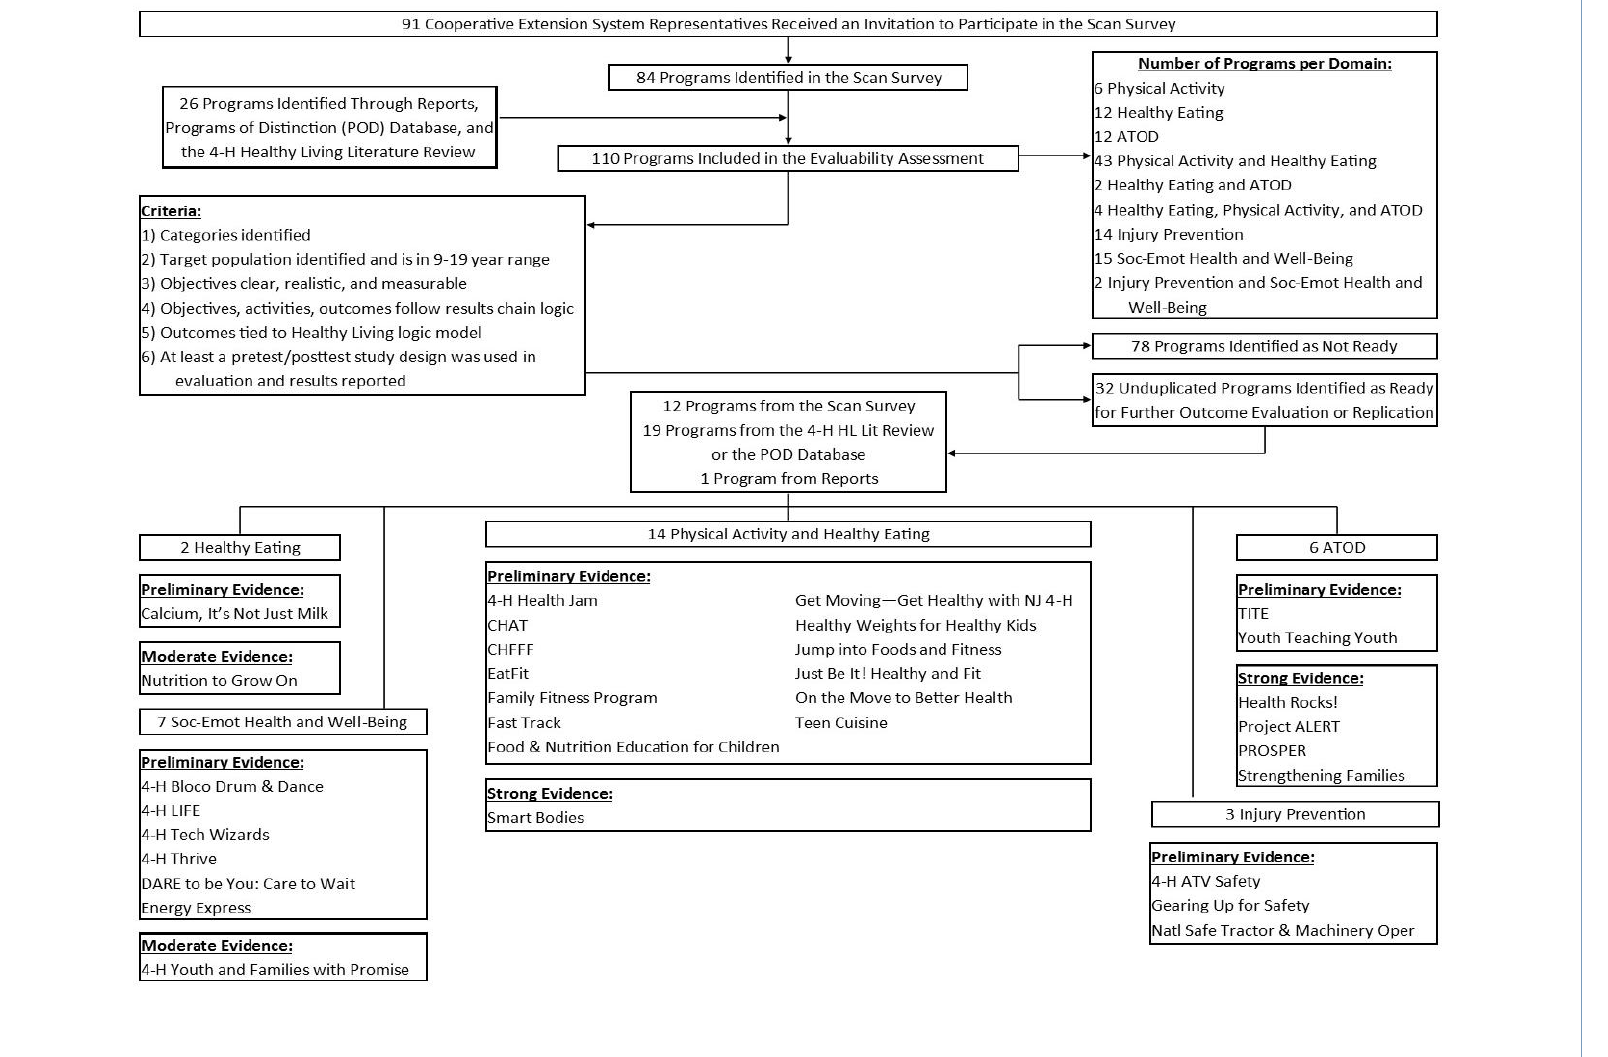
Figure 1. Overall Flow Scheme for the Systematic Screening and